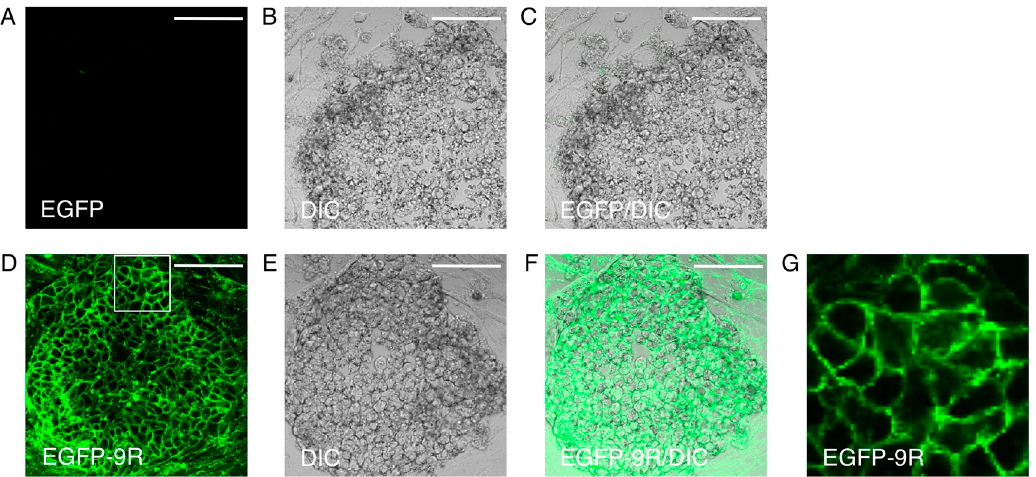
Figure 2. Protein transduction into human iPS cells. Human iPS cells of 201B7 were treated with EGFP or 9R-EGFP for 6 h at a final concentration of 1 µM and GFP fluorescence was analyzed by confocal microscopy. ( A – C ) EGFP-treated cells. Images of EGFP fluorescence ( A ); DIC ( B ) and their merge ( C ) were shown. ( D – F ) EGFP-9R-treated cells. Images of EGFP fluorescence ( D ); DIC ( E ) and their merge ( F ) were shown; ( G ) Magnified image of indicated area by white box in ( D ). GFP fluorescence was detected in the cytoplasm and cell membrane. Scale bars are 100 µm. 9R, nine arginines. DIC, differential interference contrast.